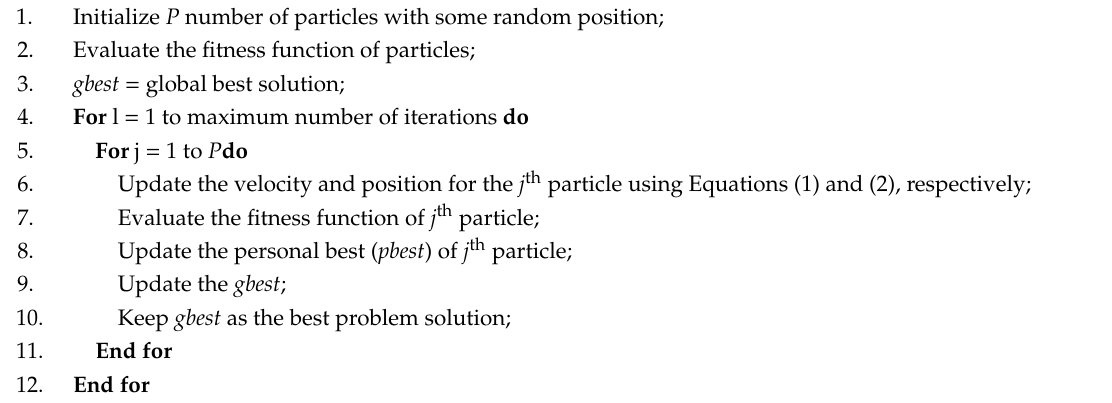
Algorithm 1: The PSO algorithm for optimization problem of d -dimensional decision